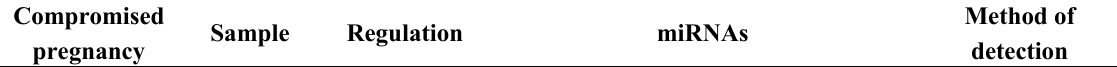
Table 2. Aberrant expression of miRNAs in compromised